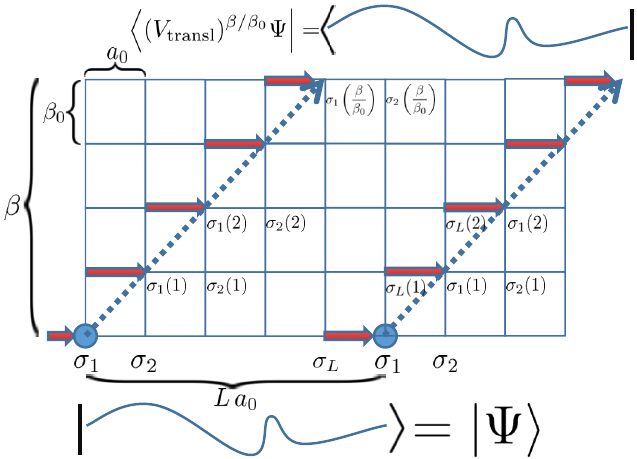
Figure 3 . The visualization of the partition function Z latt : the dashed arrows point along the vector r,s ( τ 1 , τ 2 ) and the state | Ψ i is summed over. The solid arrows denote the r -twisted link between the sites L and 1 and the correspondng links moved by V transl during the time evolution. The temporal s -twisting is not shown explicitly in this